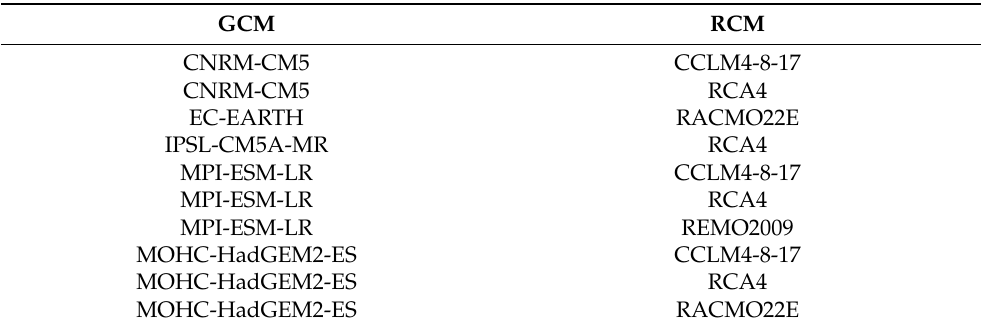
Table 1. Combinations of the Global Climate Models (GCM) and the Regional Climate Models (RCM) used in this study. GCM RCM